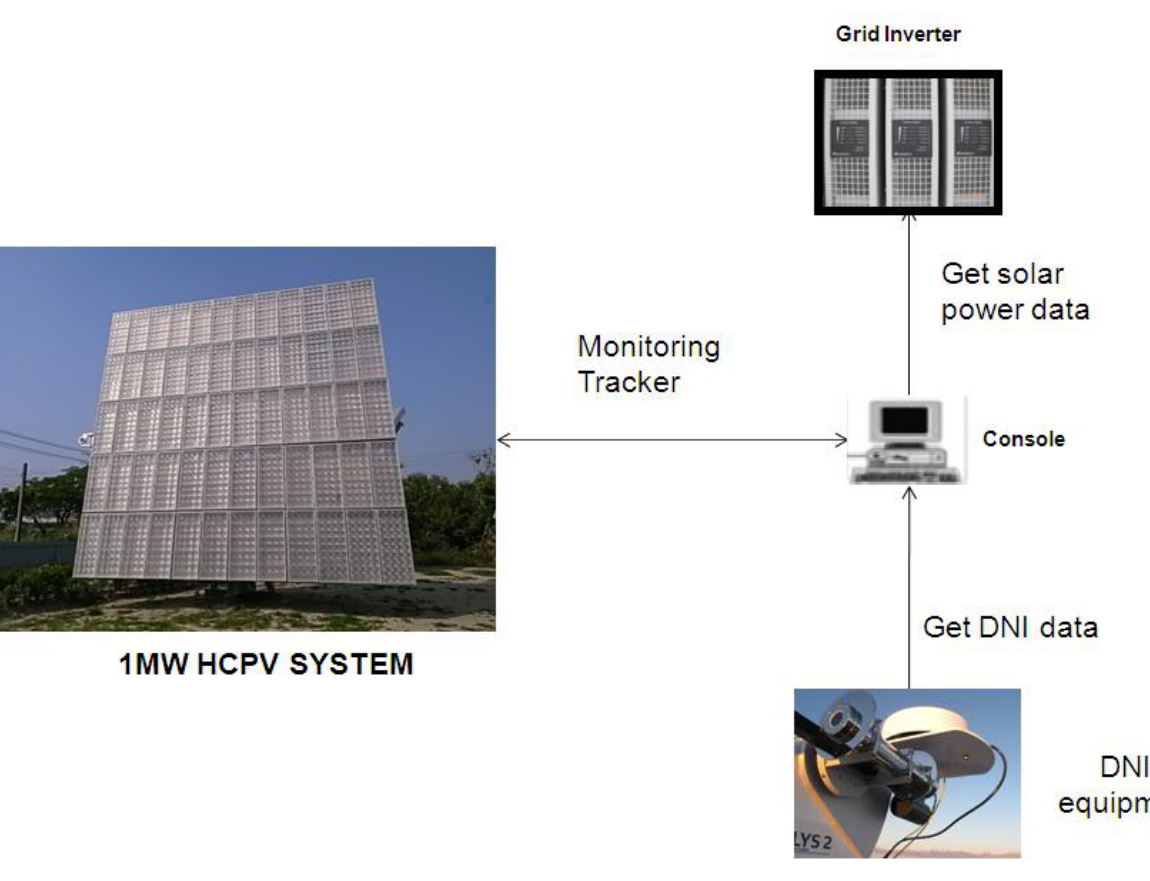
Figure 9. Block diagram of experiment